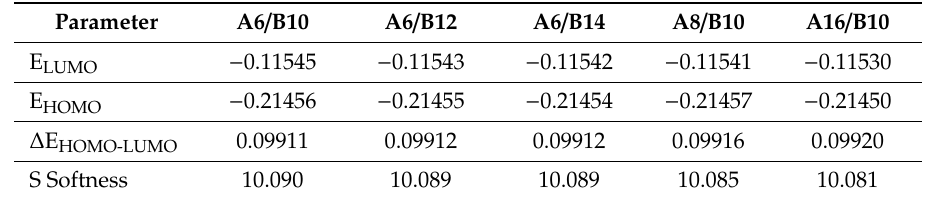
Table 4. Frontier Molecular Orbitals (FMO) energies a.u., polarizability α , and dipole moment µ (Debye) of conformers of the di-nicotinate base and SMHBCs An / Bm .